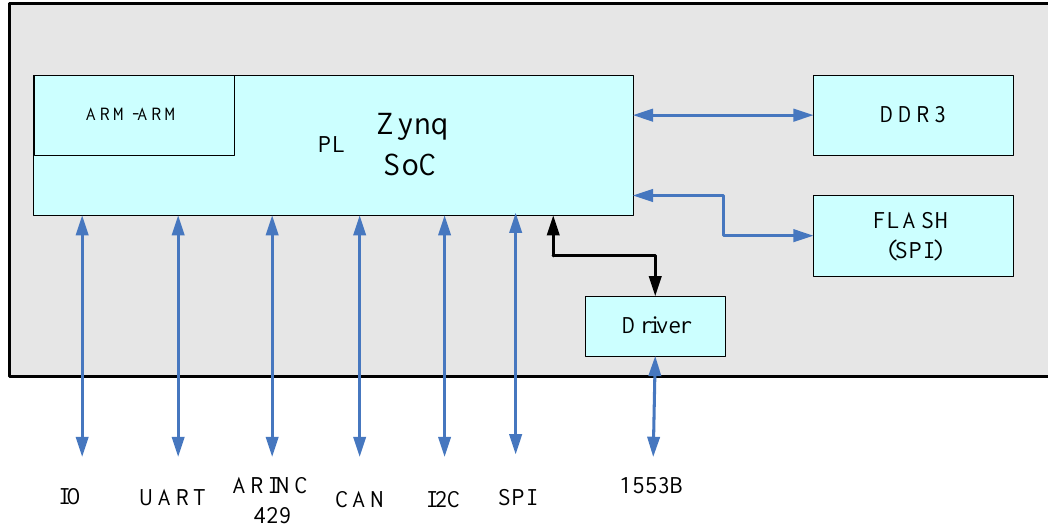
Figure 1. Internal structure of the system in package (SIP) chip.